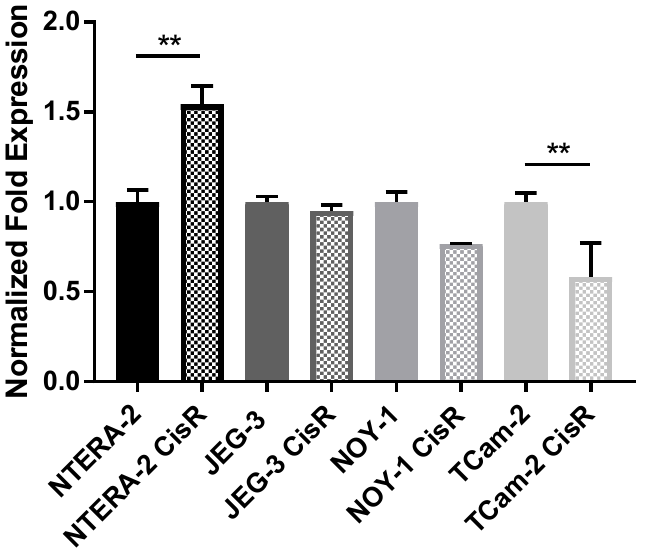
Figure 1. Relative apoptosis-Inducing Factor (AIF) expression in different GCTs cell lines on mRNA level by qRT-PCR. ** p < 0.01